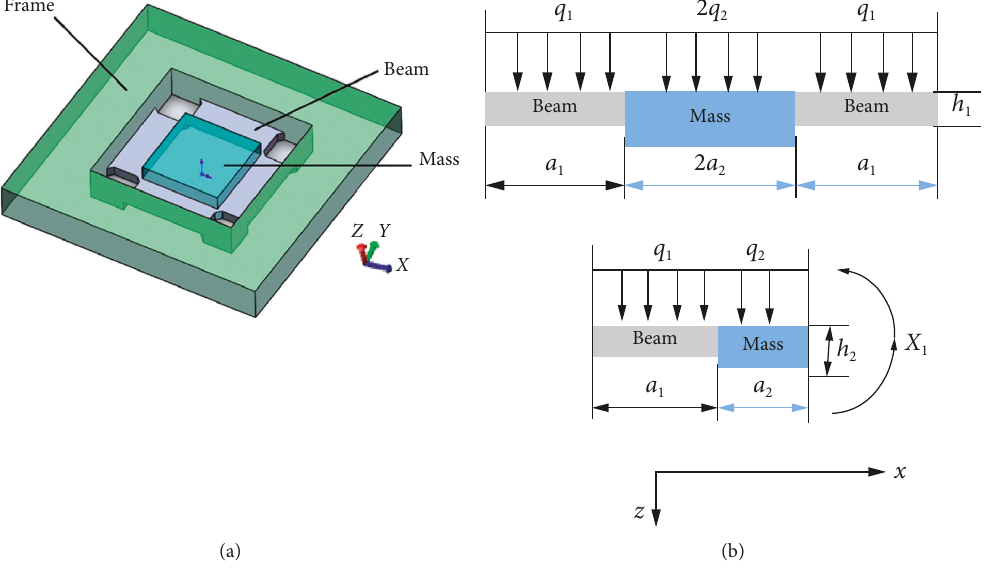
Figure 4: High-G MEMS accelerometer structure diagram and